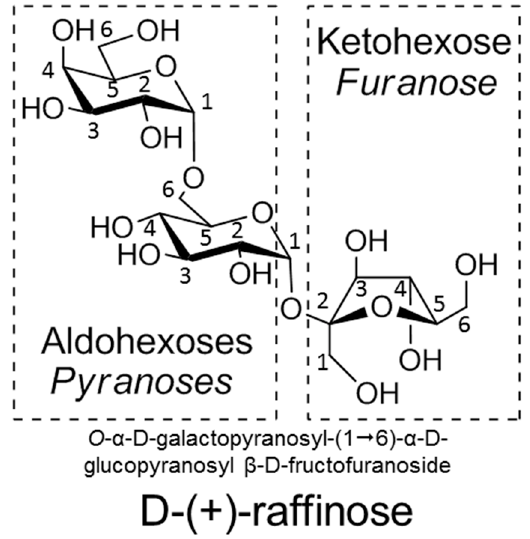
Figure 1. The nomenclature of glycosides and oligosaccharides.